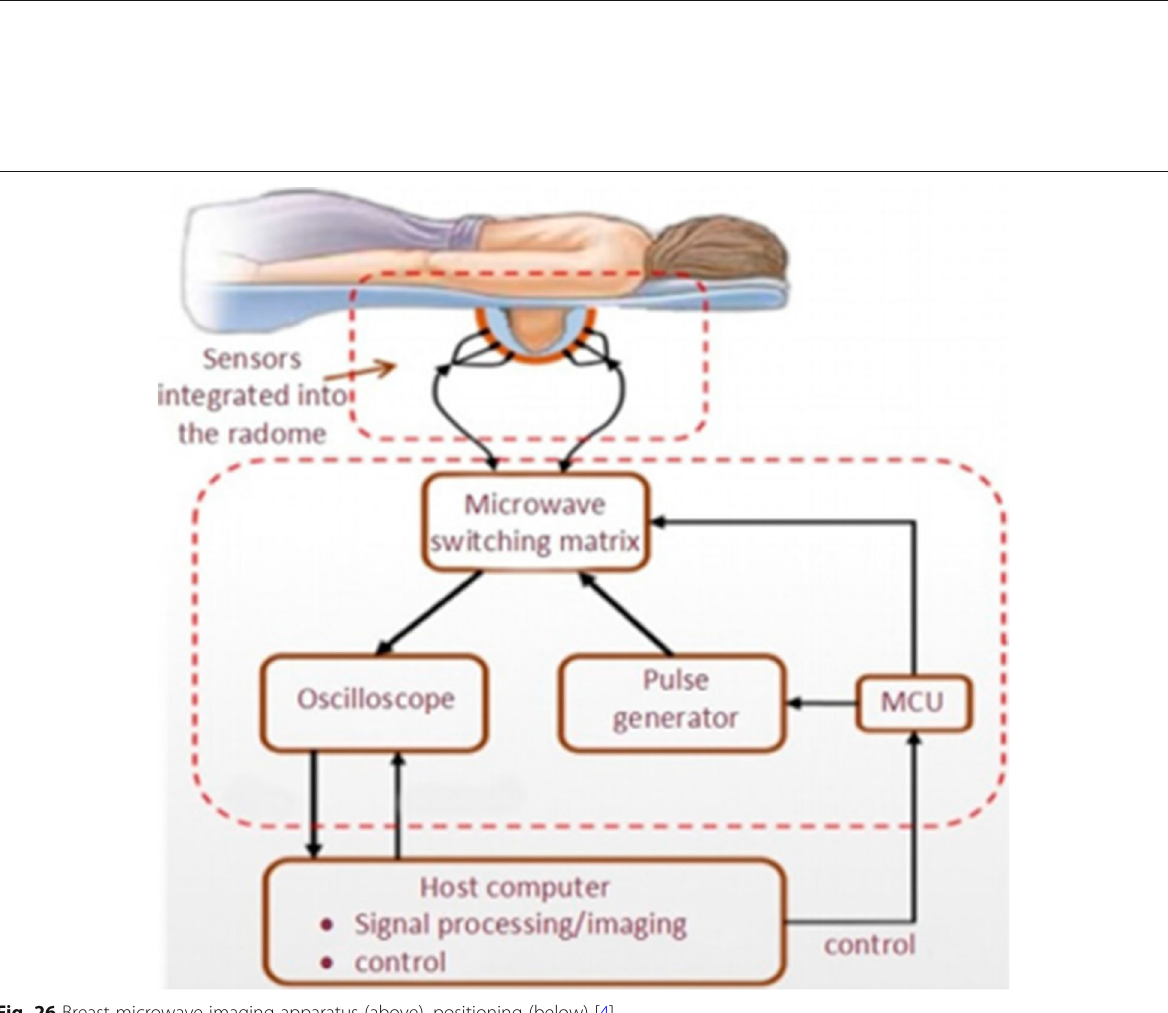
Fig. 26 Breast microwave imaging apparatus (above), positioning (below)